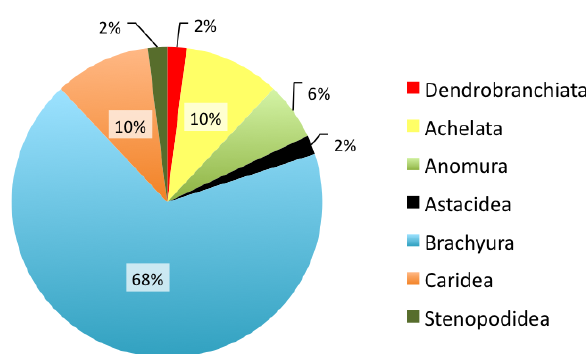
Figure 3. Richness of infraorders of Decapoda registered in the Crustacea collection of